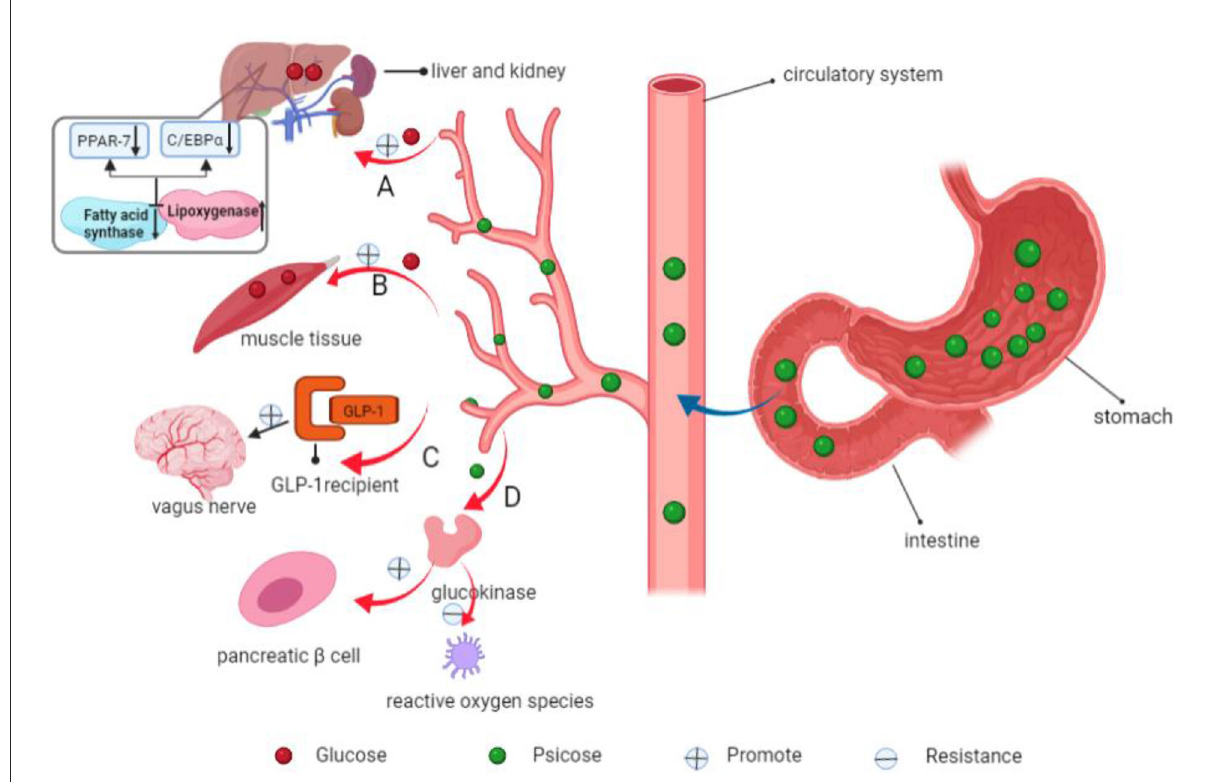
FIGURE8 Mechanisms of psicose in decreasing blood glucose levels and inhibiting fat accumulation. (A) Psicose inhibits fatty acid synthase and promotes lipoxygenase activities, down-regulates the expressions of fat synthesis-related PPAR-7 and C/EBP α genes. In addition, it promotes the use of glucose in the liver and synthesis of liver glycogen. (B) Psicose promotes muscle glycogen synthesis. (C) It promotes the secretion of GLP-1 and activates the GLP-1 receptor to stimulate the vagal afferent nerve, allowing people to develop satiety. (D) Moreover, it stimulates glucokinase to maintain a normal GI and insulin receptor sensitivity. It scavenges for reactive oxygen species, thereby exerting antioxidant effects and plays a role in protecting pancreatic β